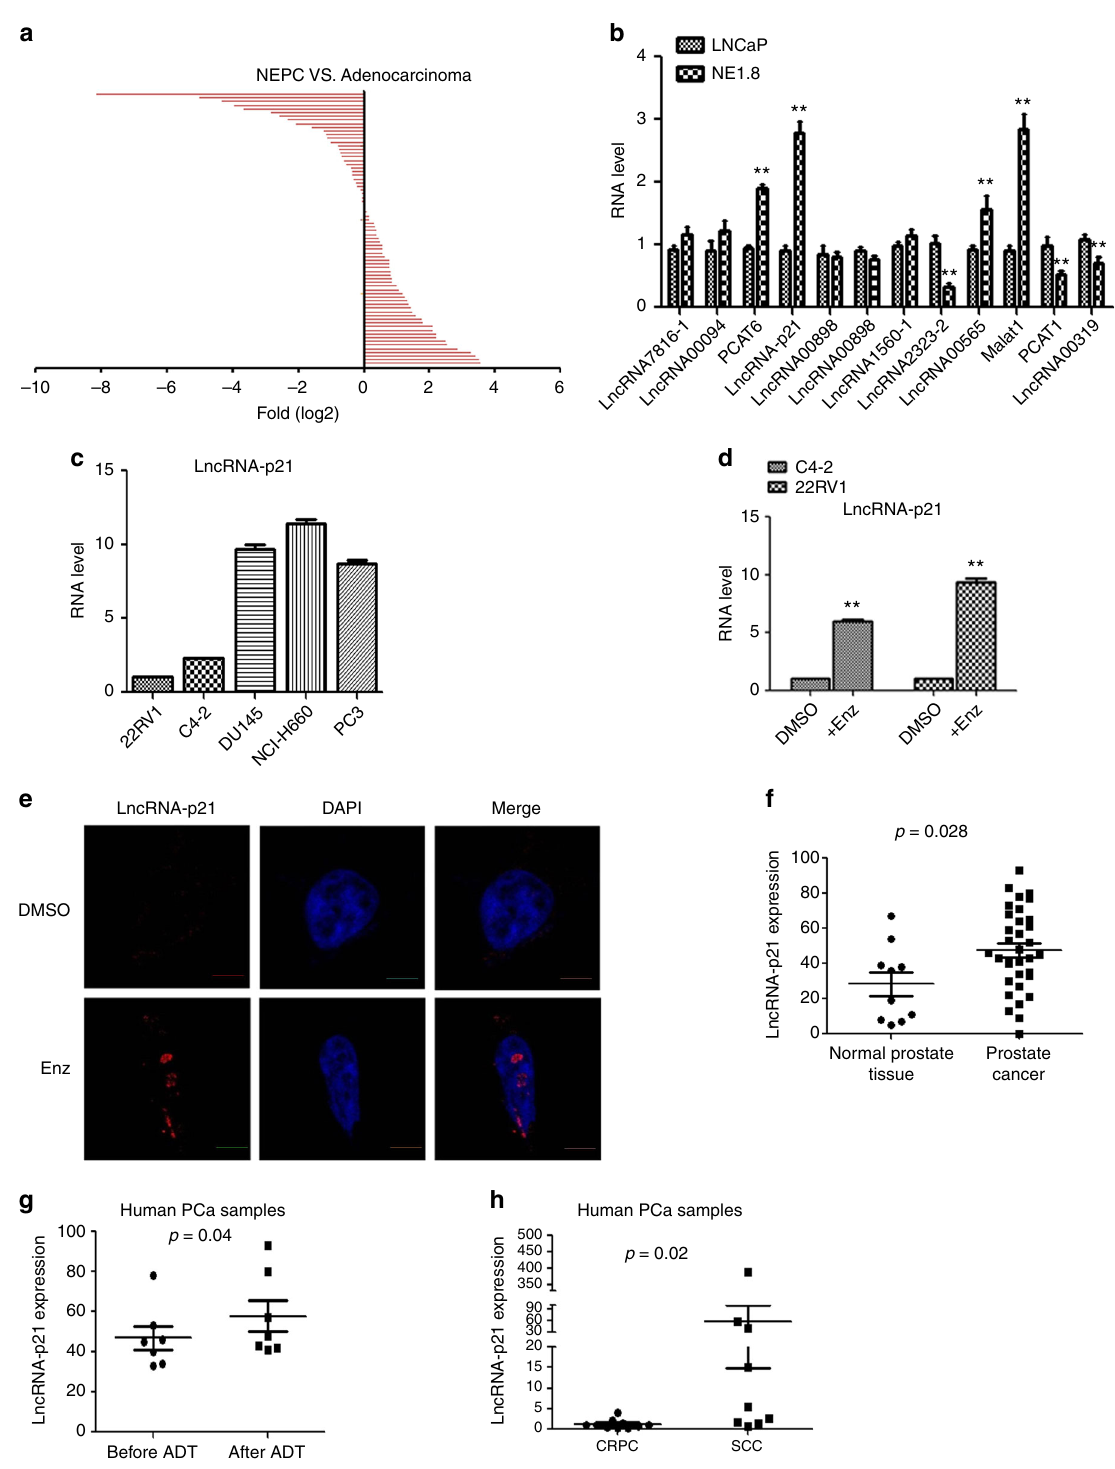
Fig. 1 The lncRNA-p21 level is increased in NEPC cells. a The qPCR analysis to detect 75 lncRNAs expressed in NEPC-PDX and adenocarcinoma-PDX samples. b Detecting lncRNAs expressions in LNCaP and NE1.8 cells by qPCR analysis. c The qPCR analysis of lncRNA-p21 expression in CWR22RV1 (22RV1), C4-2, DU145, NCI-H660, and PC3 cells. d The qPCR analysis of lncRNA-p21 expression in C4-2 and 22RV1 cells after Enz treatment. e Detecting the lncRNA-p21 expression in Enz-treated C4-2 cells by RNA in situ hybridization (Scale bar = 2 μ m). f The lncRNA-p21 expression in human normal prostate tissues ( n = 10) and human PCa tissues ( n = 34). g The lncRNA-p21 expression in PCa tissues before and after ADT ( n = 7). h Detection of lncRNA-p21 level in human CRPC ( n = 10) and PCa small cell carcinoma (SCC) ( n = 10) samples. For B and D, data are presented as mean ± SD, ** p < 0.005, by t-